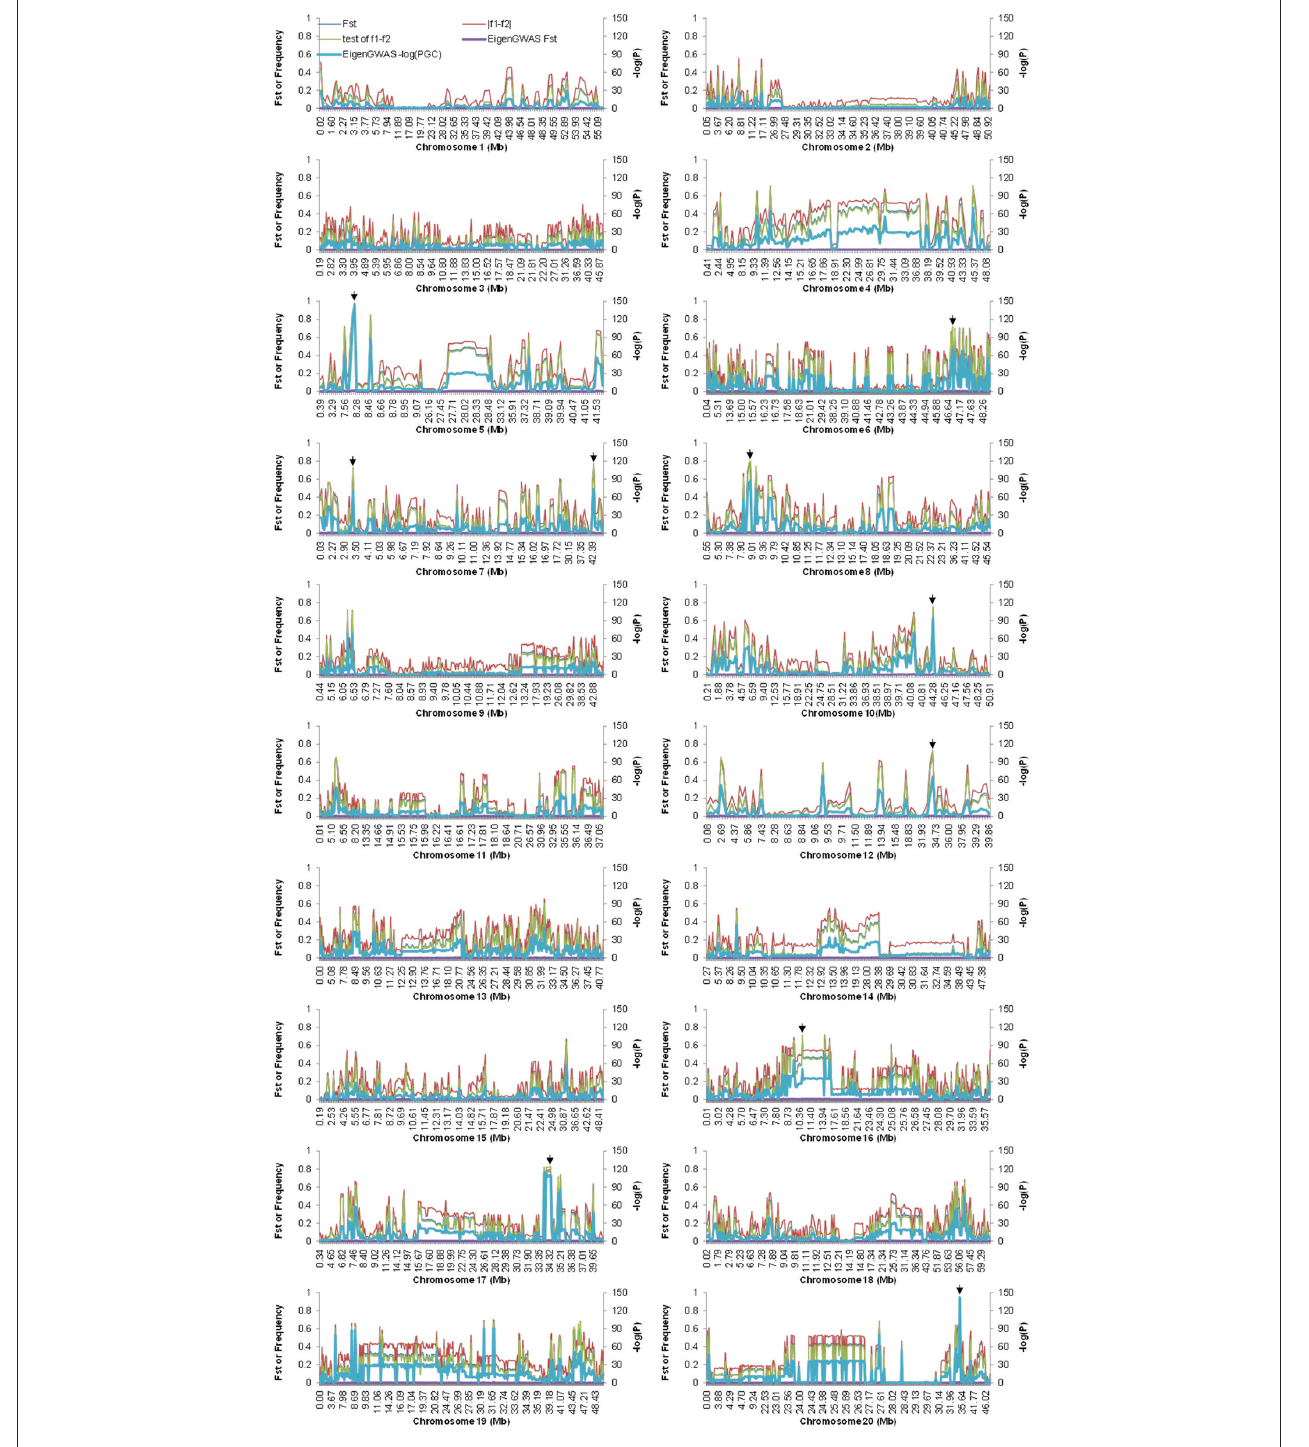
FIGURE 7 | F ST -values and the allele difference for the whole genome among Chinese and American soybean accessions. F ST were calculated from VCFtool and EigenGWAS, denoted by F ST and EigenGWAS F ST , respectively. PGC were P- values corrected by genomic control, which were calculated by EigenGWAS. To demonstrate the plot clearly, the values of − log(PGC) were multiplied by 20. Arrows indicate the physical positions of the top 10 candidate loci under selection.